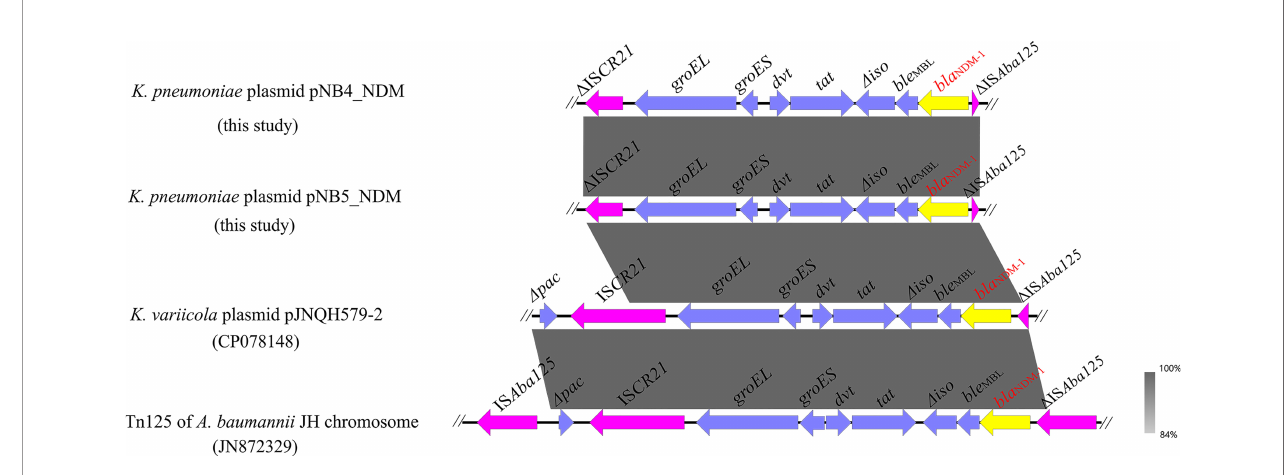
FIGURE 3 | Genetic context of bla NDM-1 located on plasmids pNB4_NDM and pNB5_NDM compared with other similar sequences. The yellow arrows indicate the bla NDM-1 genes.